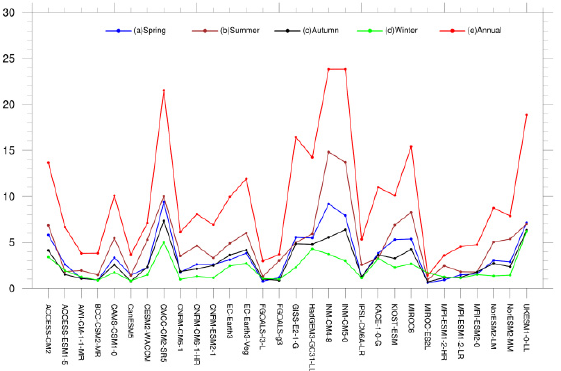
Figure 5. Interannual variability score ( IVS ) of the CMIP6 models in terms of seasonal and annual NWS over China.